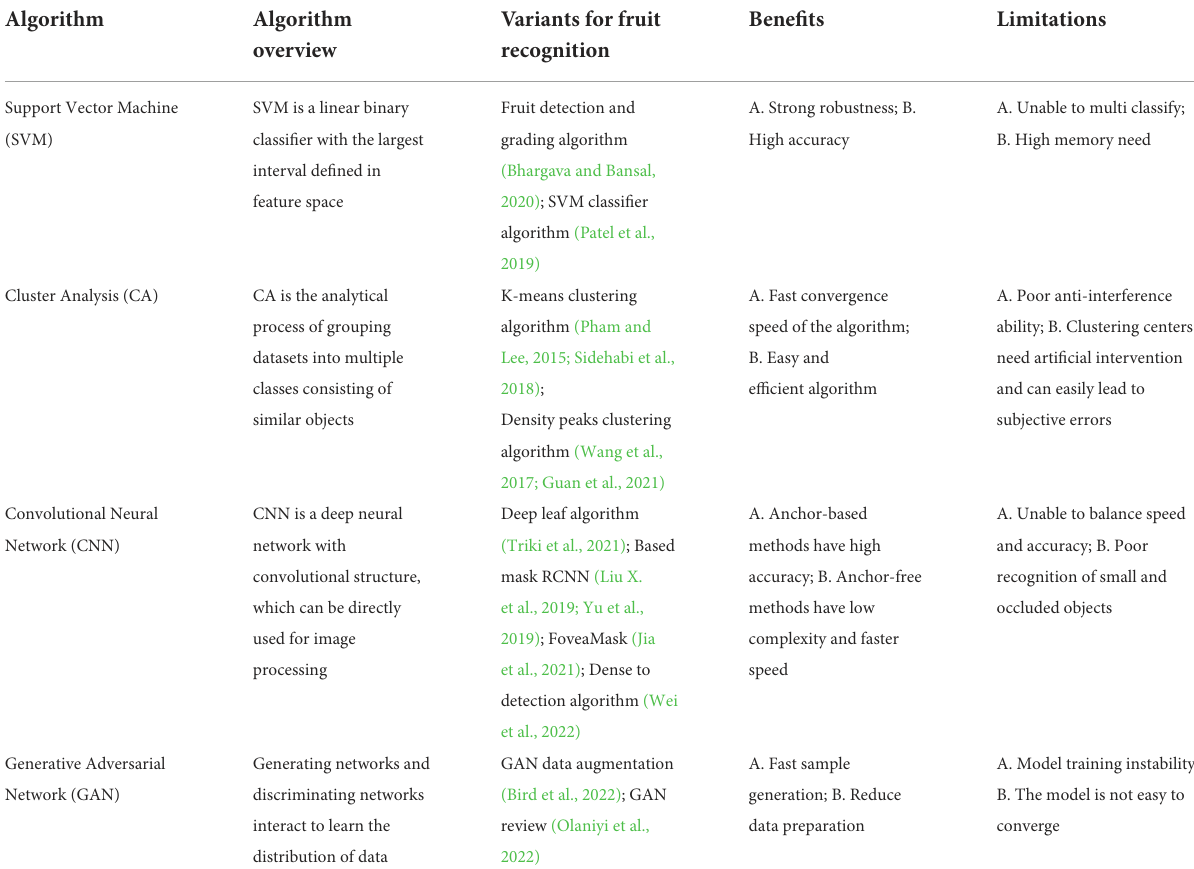
TABLE 1 Overview of previous research